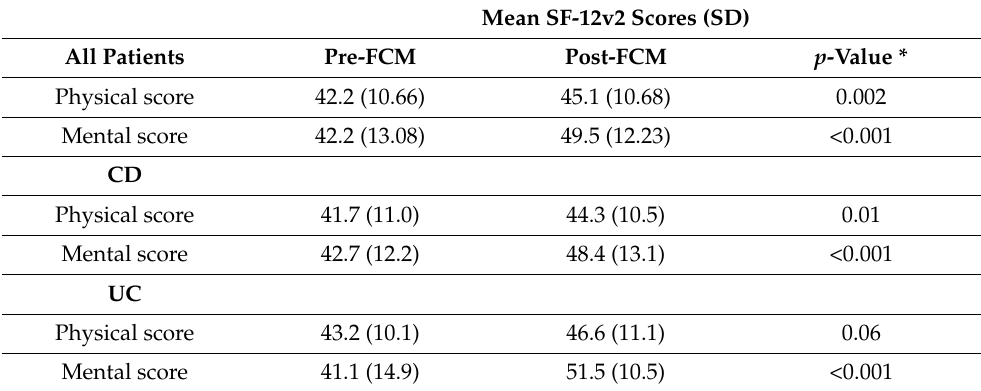
Table 6. SF-12v2 scores before and after administration of